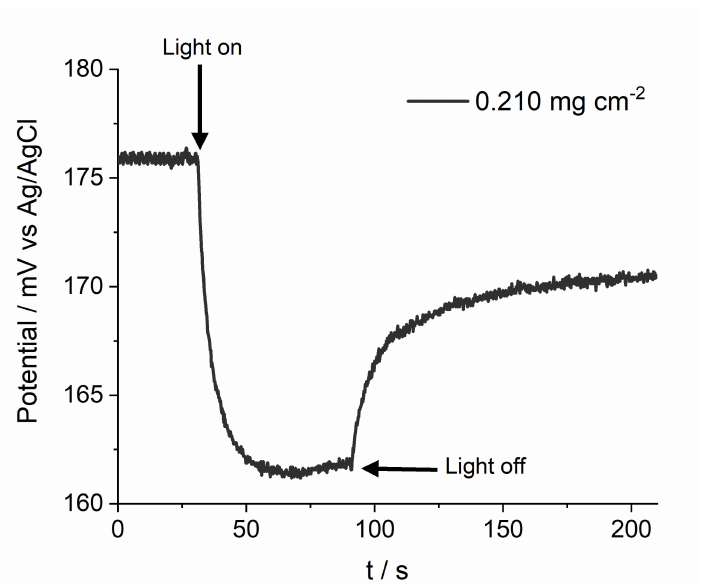
Figure 4. Open circuit potential of g-C 3 N 4 layer (content 0.210 mg cm − 2 ) on FTO glass. Electrolyte 0.1 mol dm − 3 Na 2 SO 4 , 1.5 G simulated solar light, light irradiance 100 mW cm − 2